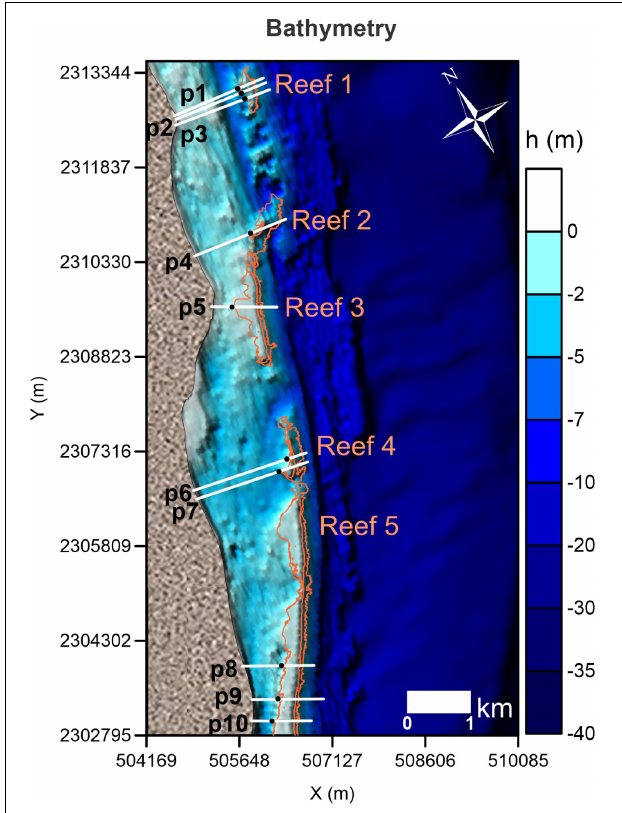
FIGURE 2 | Bathymetric map showing the position of the reefs and the beach profiles used in the analysis